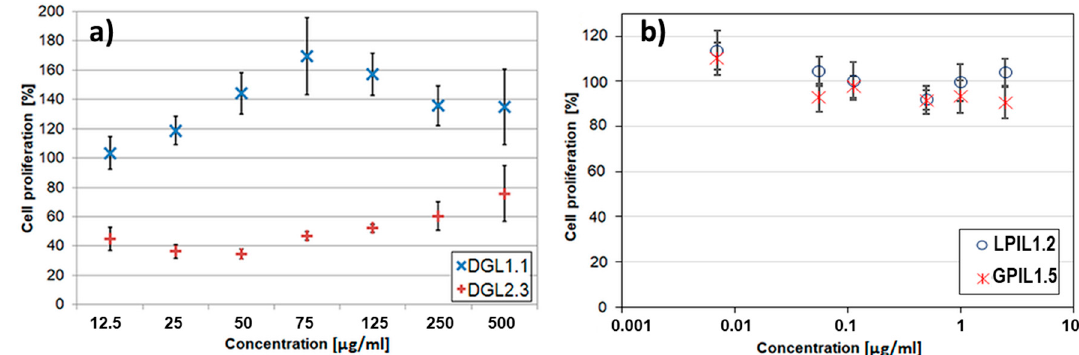
Figure 8. In vitro cytotoxicity effect of polymethacrylate carriers containing carboxylic (DGL1.1) or amine groups (DGL2.3) without drug on MCF-7/R cells ( a ), and trimethylammonium groups with salicylate anions (GPIL1.5, LPIL1.2) towards BEAS-2B cells ( b ).